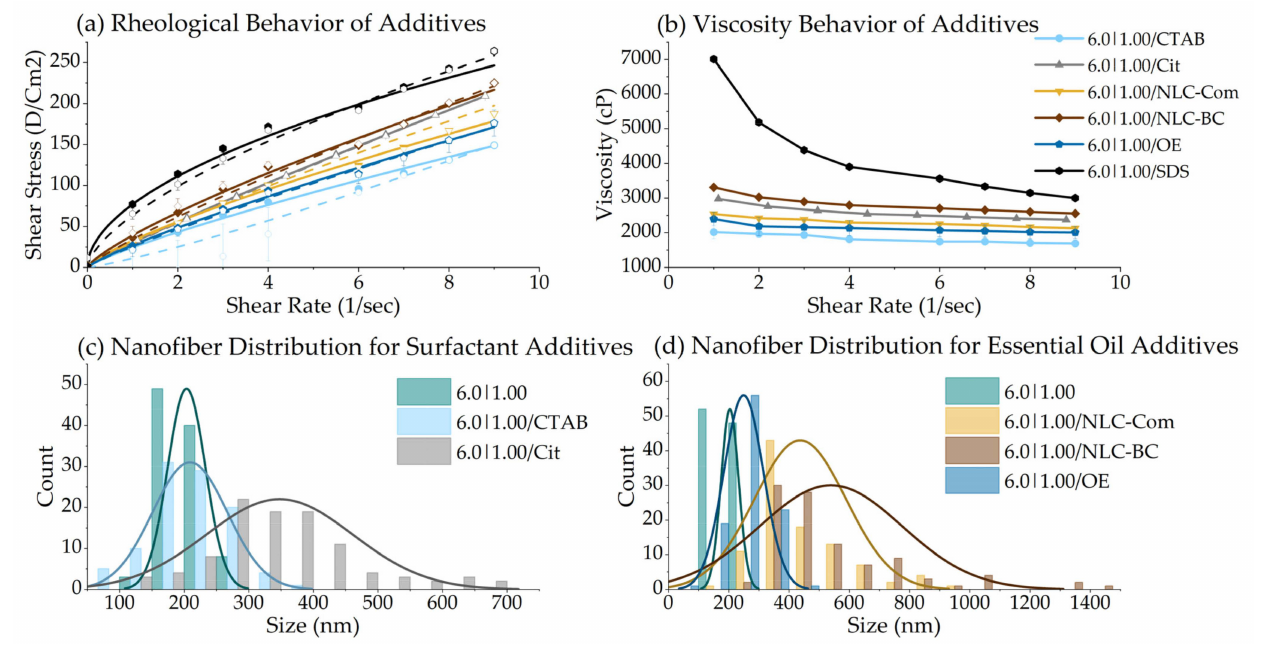
Figure 10. ( a ) Rheograms for the PVA 6.0|CS 1.00 solution with additives, analyzed at 0 to 10 s − 1 . Close dots and solid lines show the increase in shear stress, while open dots and dash lines show tensile stress relaxation. ( b ) Viscosity behavior of the samples under increasing shear stress; ( c ) fiber size distribution for the samples with surfactants as additives; and ( d ) fiber size distribution for the samples with essential oil and NLCs as